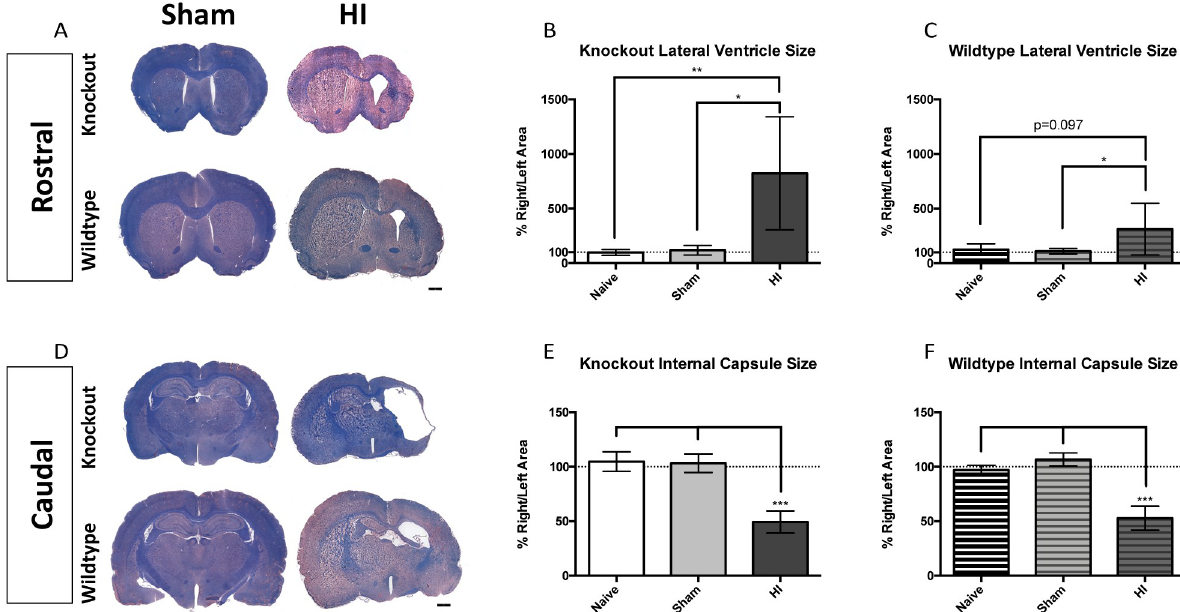
Fig 9. Lateral ventricle and internal capsule injuries. (A) Representative LFB/HE stained sections of Sham (left) and injured (right) animals of both genotypes at the rostral level. KO injured rats displayed significantly enlarged right ventricles (B), and there was a similar trend toward significance in WT rats (C). (D) Representative LFB/HE stained sections of Sham (left) and injured (right) animals of both genotypes at the caudal level. Both KO (E) and WT (F) injured animals exhibited a significant reduction in right internal capsule size. Scale bars = 1000 μ m, 5x. Error bars = ± SD. � p < 0.05, �� p < 0.01, ��� p <